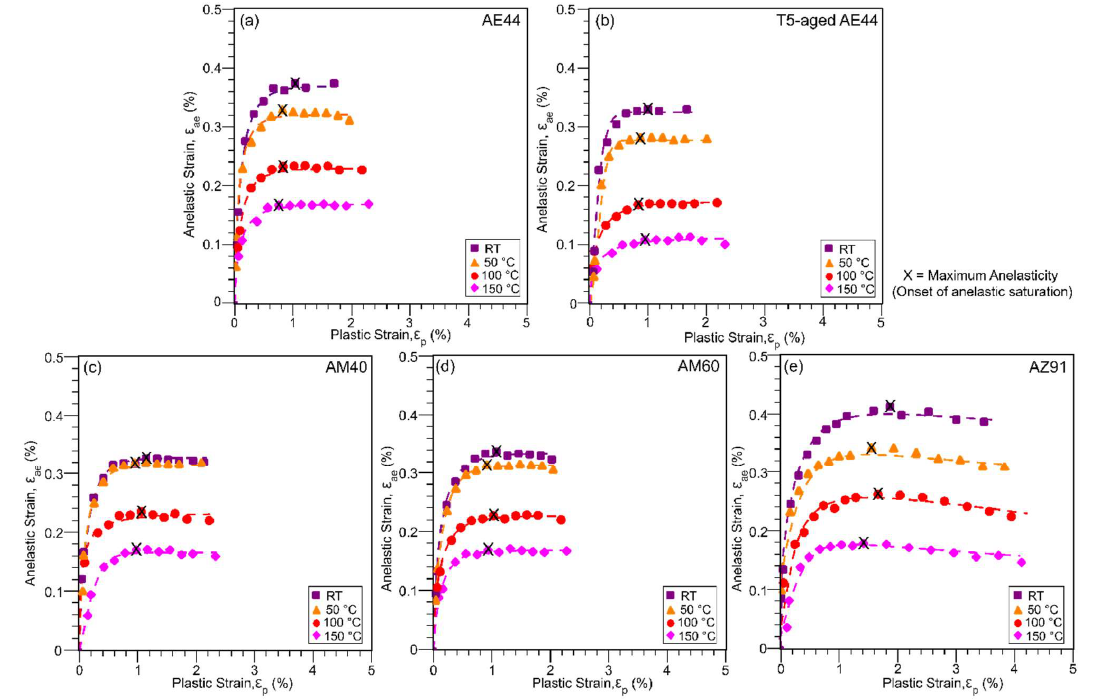
Figure 4. Anelastic strain, ε ae , as a function of the applied plastic strain, ε p , for ( a ) AE44, ( b ) T5-aged AE44, ( c ) AM40, ( d ) AM60, and ( e ) AZ91, at RT and elevated temperatures. Maximum anelasticity indicates the onset of anelastic saturation, as marked by the symbol ‘X’.